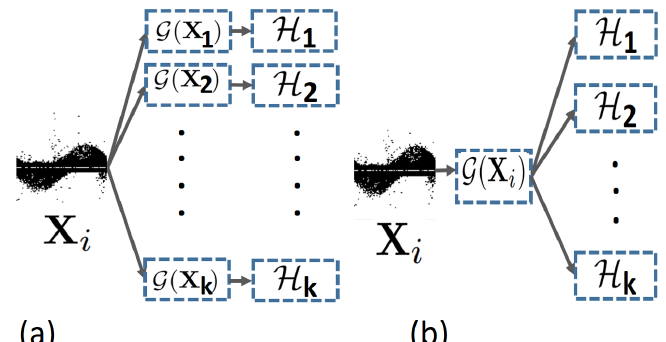
Figure 7. ( a ) baseline model with independent model for each class ; ( b ) proposed model with a common convolutional backbone shared across all